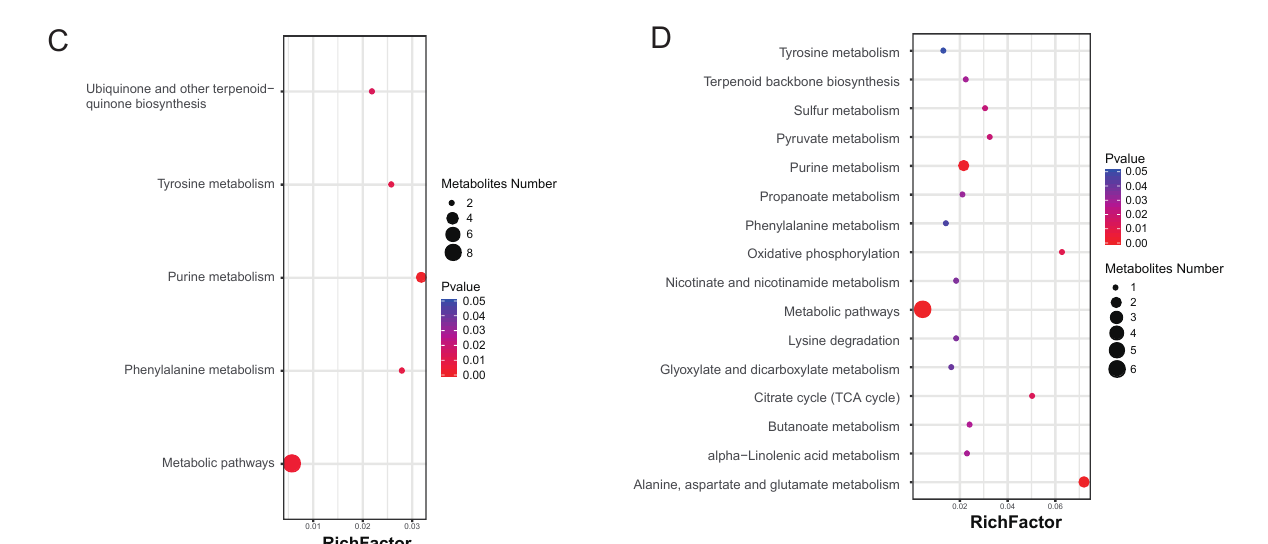
Figure 5. Metabolite production is disrupted in Bm5 (cid:48) N mutant. ( A , B ) Volcano plot of metabolites differentially expressed in malpighian tubules of WT and ∆ Bm5 (cid:48) N in ( A ) positive ion mode and ( B ) negative ion mode. Green, down-regulated metabolites; red, up-regulated metabolites; purple, no significant difference in metabolites. Differentially produced metabo- lites were identified by the following criteria: p -value < 0.05; Variable Important for the Projection ≥ 1; Fold-Change ≥ 1.2 or Fold-Change ≤ 0.83. ( C , D ) Enrichment factors representing the differential proportion of a metabolite relative to all metabolites in this pathway for differentially produced metabolites detected in ( C ) positive ion mode and ( D ) negative ion mode. The dot size indicates the numbers of